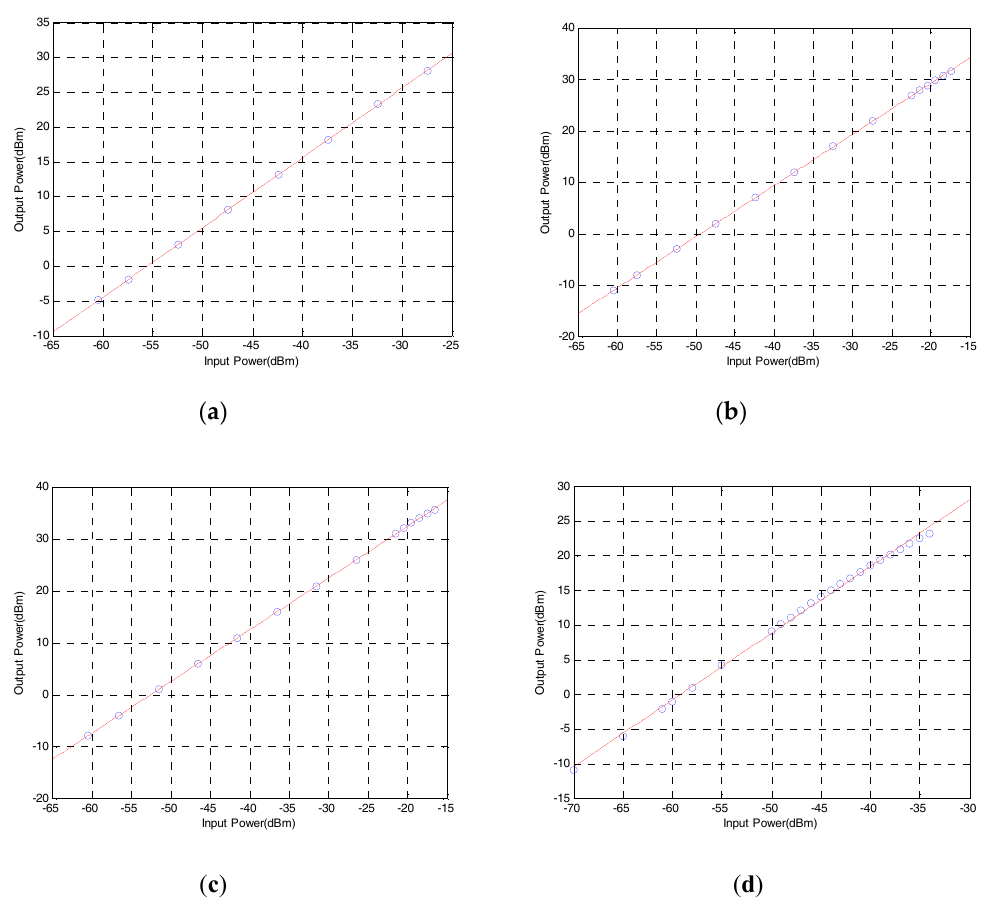
Figure 12. Transfer function: ( a ) L-band; ( b ) C-band; ( c ) X-band; ( d ) Ka-band.